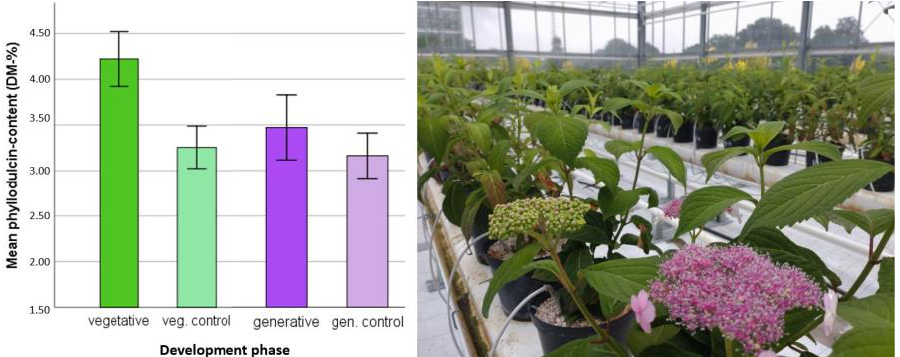
Figure 2. ( Left ) Average phyllodulcin content in leaves of different ages ( n = 15) and ( right ) in inflorescences of different developmental stages during anthesis ( n = 8, composite samples; error bars: 95% CI).